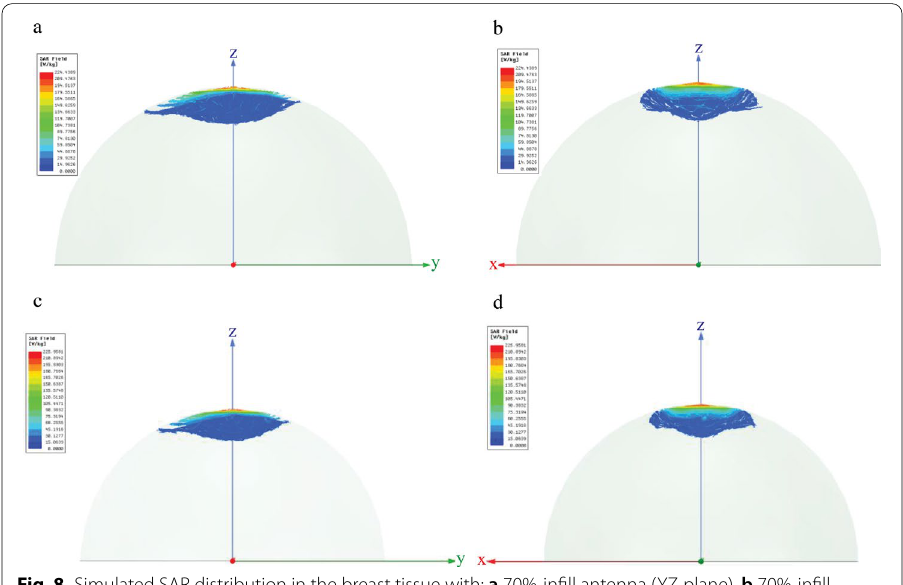
Fig. 8 Simulated SAR distribution in the breast tissue with: a 70%-infill antenna (YZ-plane), b 70%-infill antenna (ZX-plane), c 100%-infill antenna (YZ-plane), and d 100%-infill antenna